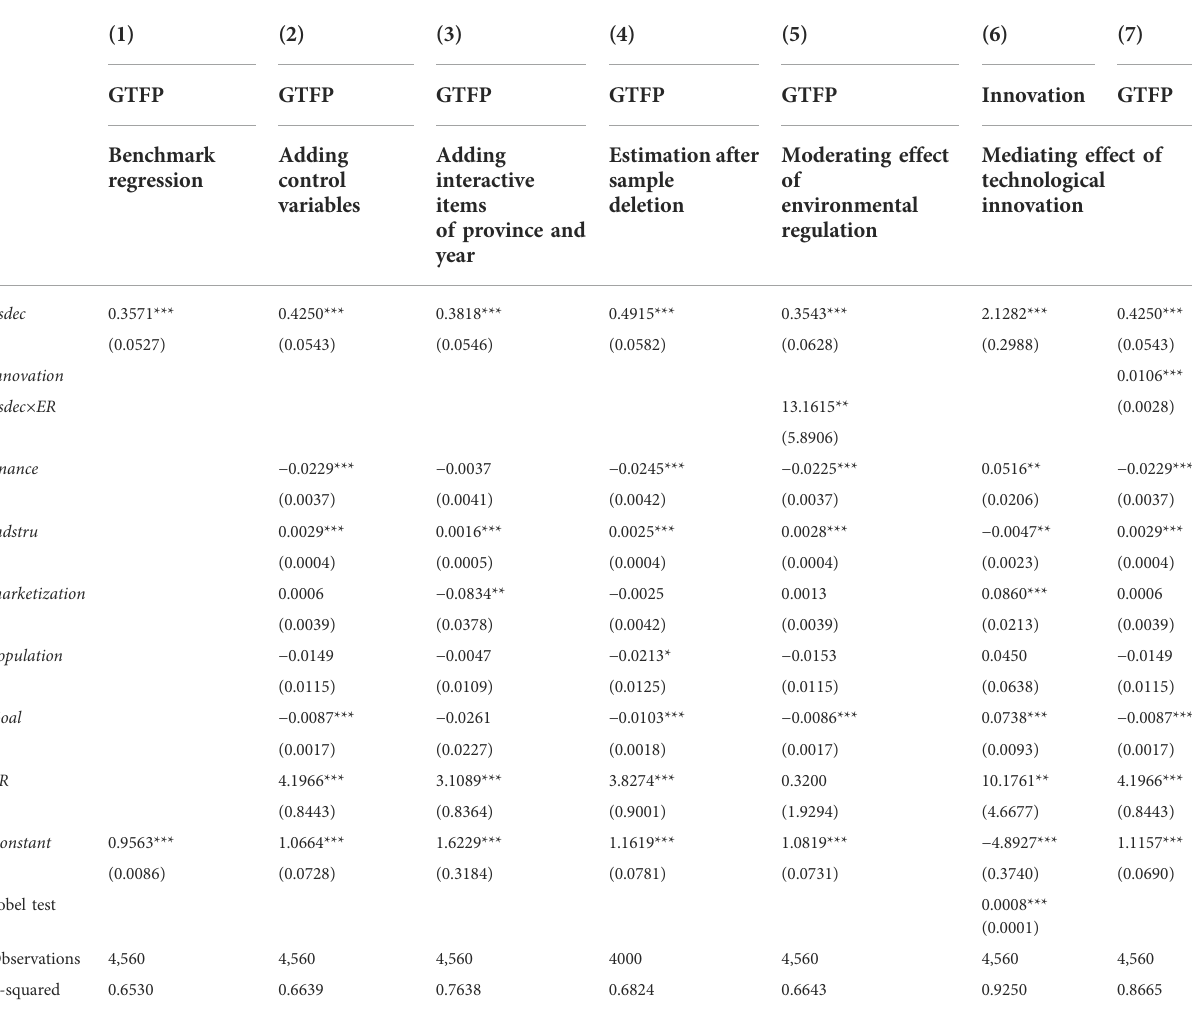
TABLE 2 Estimation